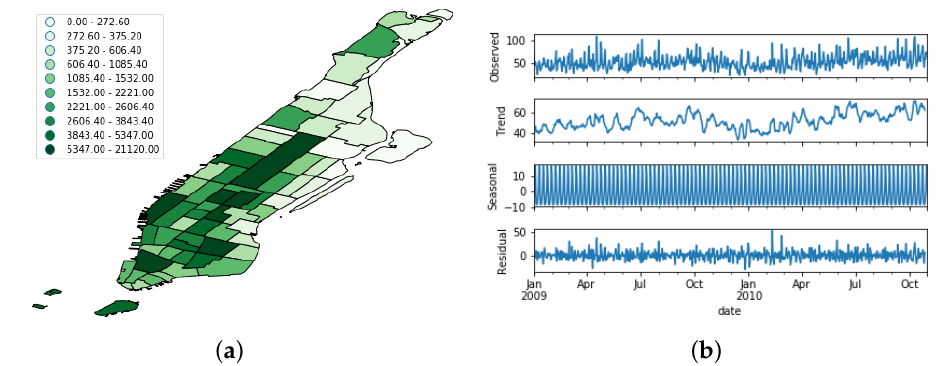
Figure 5. Distribution of the Flickr dataset. ( a ) Spatial distribution; ( b ) Temporal evolution. The uppermost figure shows the raw time series, whereas the other bottom ones depict its decomposition in trend, seasonal, and noise features.